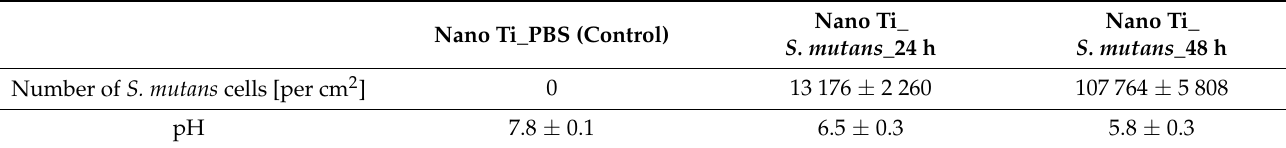
Table 2. Number of bacteria cells and pH value of the bacteria and control suspensions. Statistical significance of differences between values designated for different samples were confirmed by one-way ANOVA test ( p < 0.05). Figure 4. Calculated number of S. mutans cells per 1 cm 2 of nanostructured Ti surface and pH value of the suspension measured after bacterial incubation.